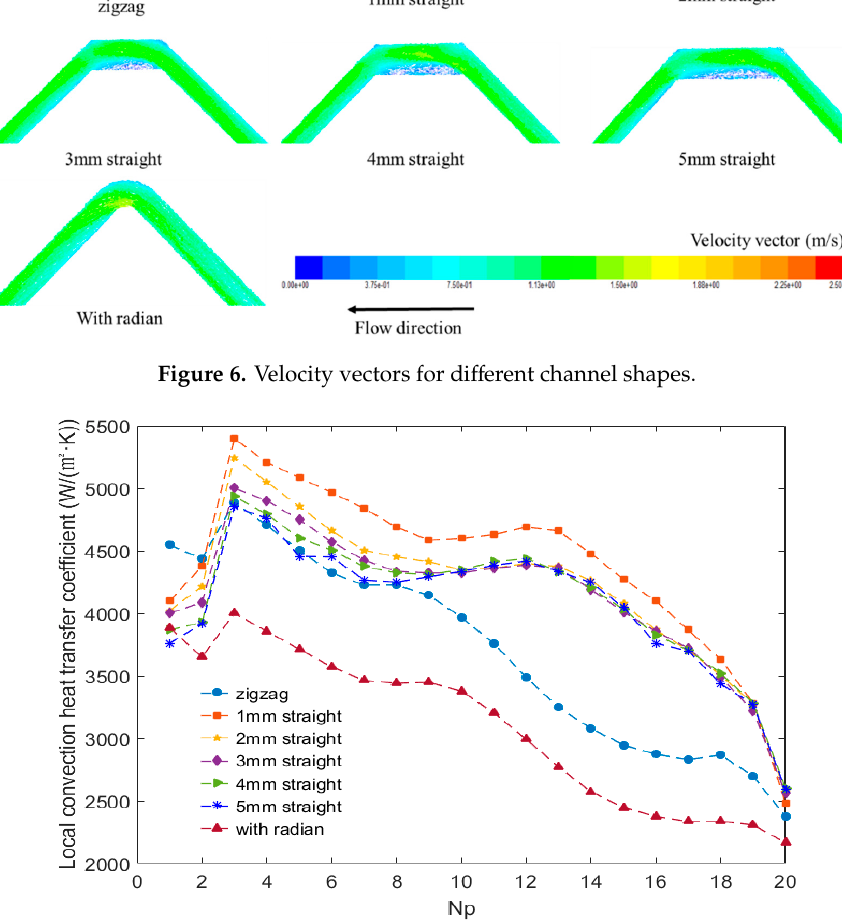
Figure 7. Local convection heat transfer coefficient along the flow direction for different channel shapes.